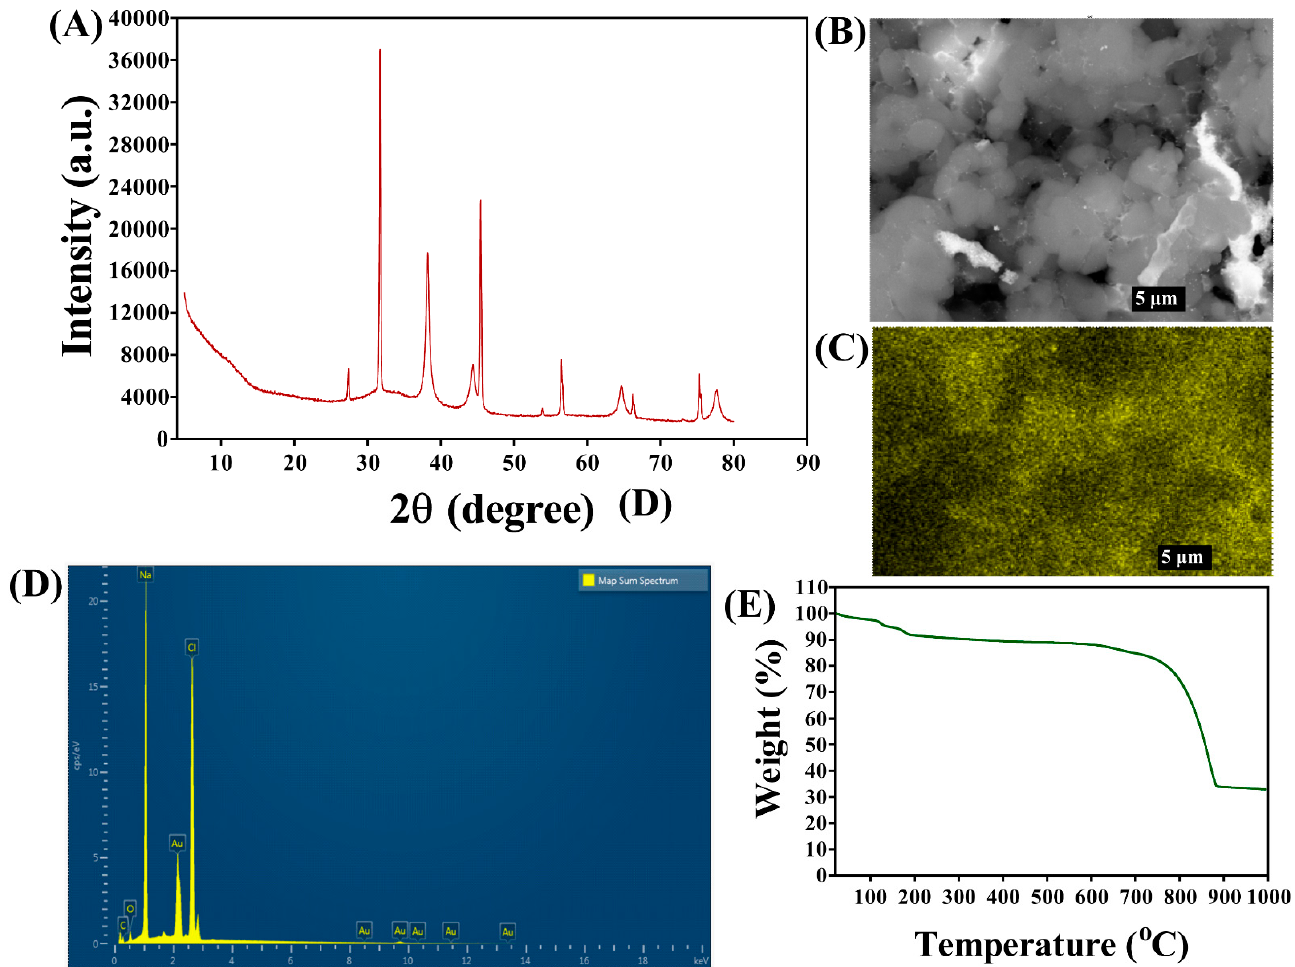
Figure 4. ( A ) XRD analysis of β -c-AuNPs, ( B ) SEM imaging, ( C ) mapping of the Au element in β -c-AuNPs, ( D ) EDX spectra, and ( E ) TGA analysis.